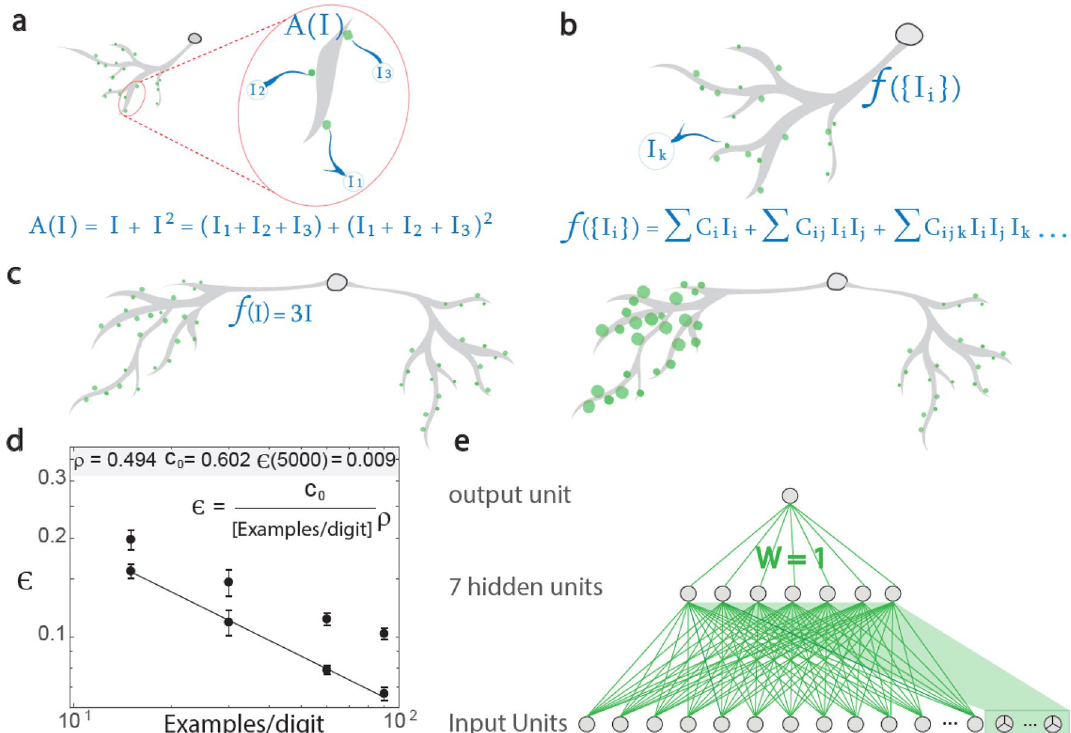
Figure 3. Biological mechanism for self-emergence of input crosses. ( a ) Zoom-in on three inputs (i.e., I 1 , I 2 , I 3 ) dendritic segment, with nonlinear amplification A ( I ) = I + I 2 , resulting in input crosses. ( b ) Combining all synaptic influx inputs I ( { I k } ) results in higher-order input crosses. ( c ) Equivalence between one amplified dendrite, f ( I ) = 3 I (left) and where amplification is shifted to its synapses (larger green-circles, right). ( d ) Log– log scale of optimized test errors for the architecture presented in Fig. 2c with additional 10,000 input crosses trained over 15, 30, 60 and 90 examples/digit and a power-law fit (line), and without input crosses (circles). Standard deviation obtained from 10 samples with different initial conditions, i.e. weights and examples. ( e ) Hebbian learning identifier for a digit, consisting of a committee of seven perceptrons, each with 10,000 input crosses of order 3 (green